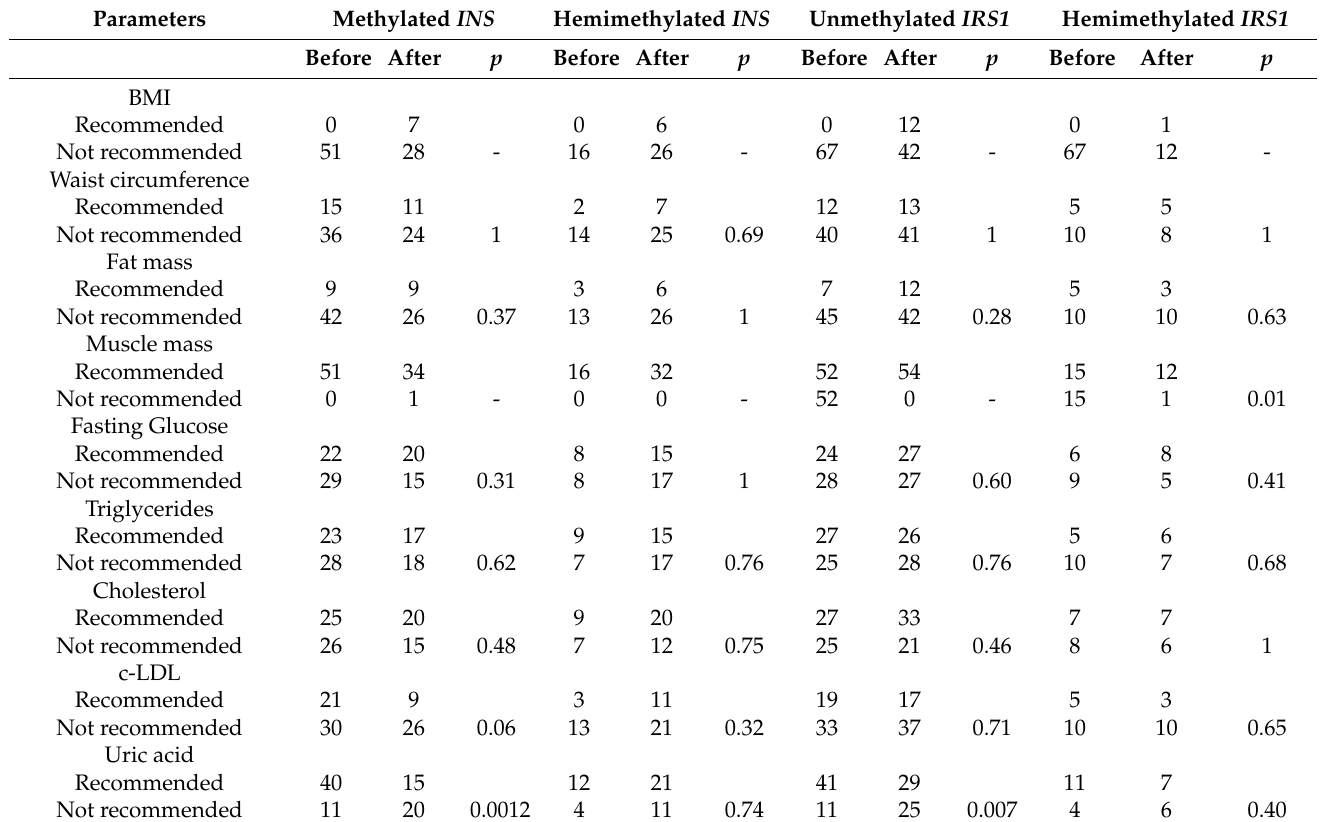
Table 4. Recommended parameters of metabolic control and methylated status of the INS and IRS1 genes before and after inulin intervention in T2DM